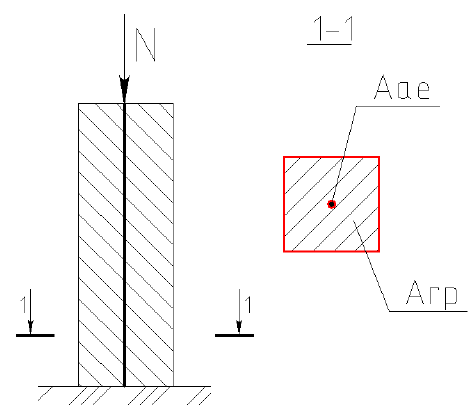
Figure 9. Soil-reinforcing element model. A rp is the cross-section area of the soil’s element, and A ae is the cross-section area of one vertical reinforcing element.